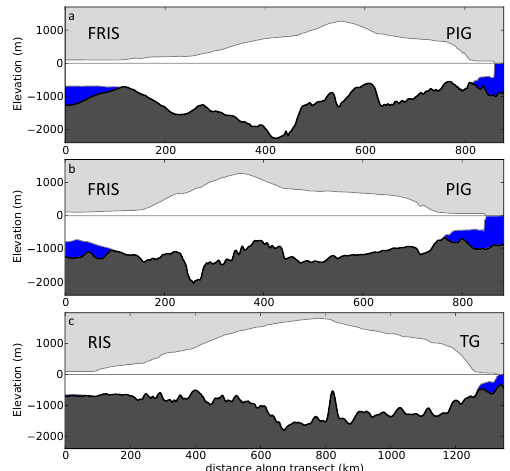
Figure 2. Cross-sections through the ice and the bed along the transects depicted in Fig. 1: bed topography (dark gray), ice sheet (white), ocean (blue). Both transects (a) and (b) connect the basins of Filchner–Ronne Ice Shelf (FRIS) and Pine Island Glacier (PIG). Transect (c) goes through the basins of Ross Ice Shelf (RIS) and Thwaites Glacier